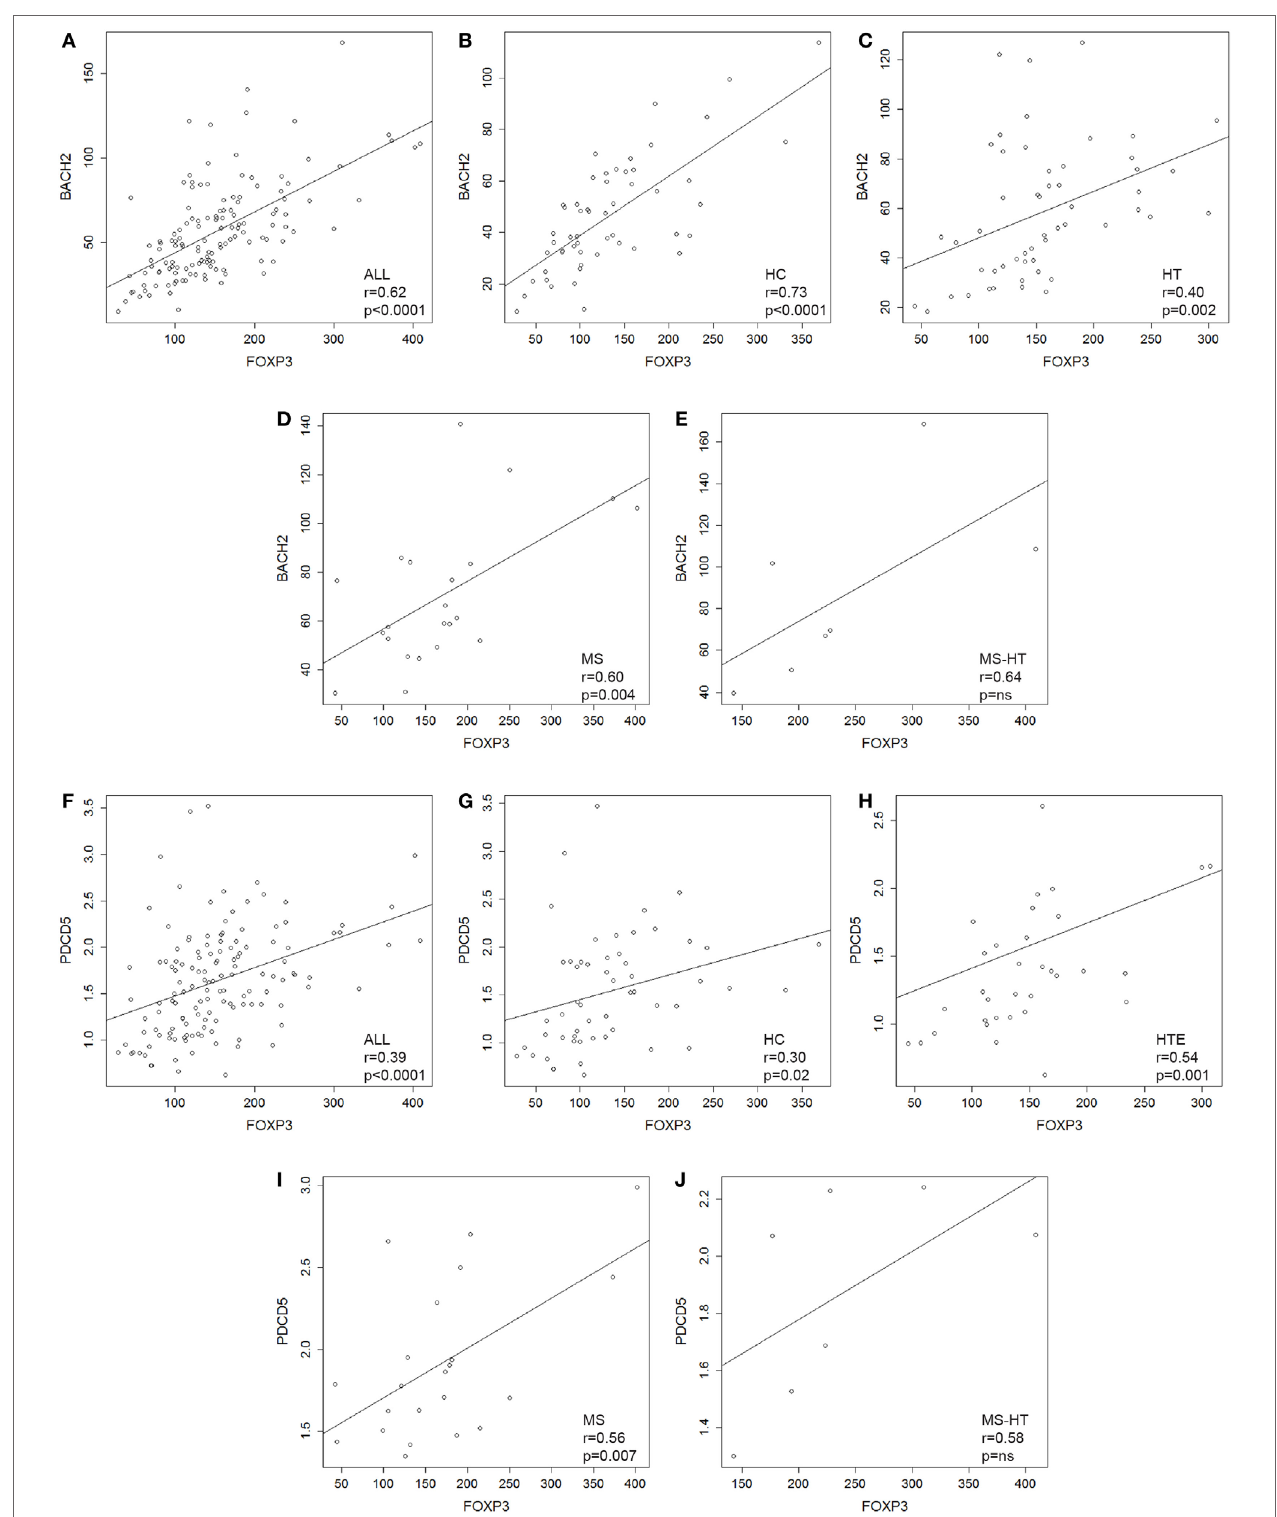
FigUre 2 | (a–e) Scatterplots showing the relationship between peripheral blood mononuclear cell (PBMC) gene-expression levels of BACH2 and FOXP3 in (a) the whole cohort of individuals and in (B) healthy control (HC), (c) Hashimoto’s thyroiditis (HT), (D) multiple sclerosis (MS), and (e) MS + HT separately. (F–J) Scatterplots showing the relationship between PBMCs gene-expression levels of PDCD5 and FOXP3 in (F) the whole cohort of individuals and in (g) HC, (h) HTE, (i) MS, and (J) MS + HT separately. Linear correlation was evaluated by Pearson’s correlation